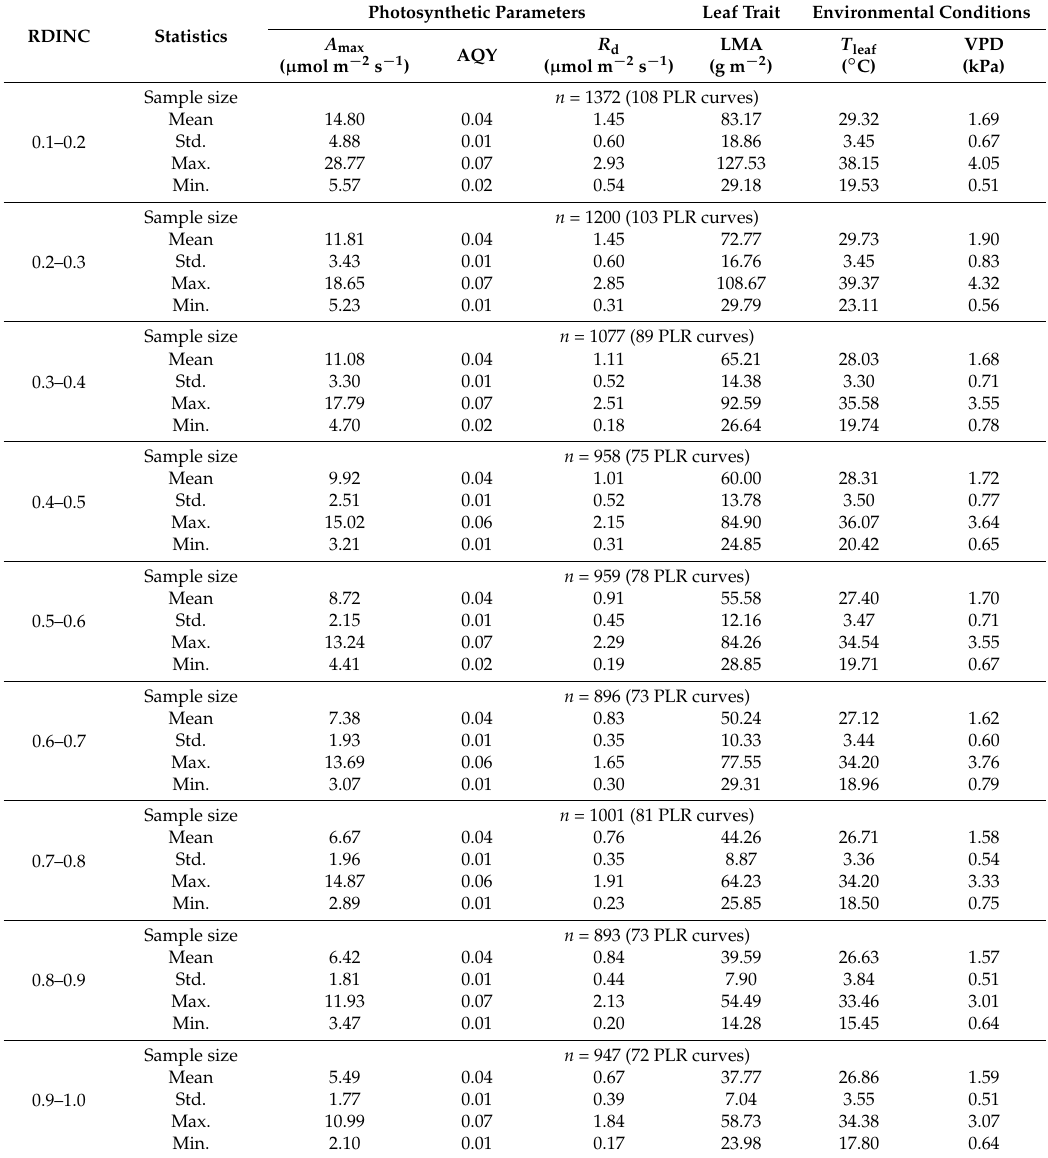
Table 1. Summary of parameters of all the photosynthetic light-response (PLR) curves, leaf traits and environmental conditions in 2016–2017. The following leaf variables are given: the maximum net photosynthetic rate ( A max ), apparent quantum yield (AQY), dark respiration rate ( R d ), photosynthetic light response curve (PLR), relative depth into crown (RDINC), leaf mass per area (LMA) leaf temperature ( T leaf ) and vapor pressure deficit (VPD). Mean, Std., Max. and Min. represent the mean value, standard deviation, maximum value and minimum value respectively. The values are based on 752 individual needle-clusters from 36 pseudowhorls belonging to five planted Larix olgensis Henry